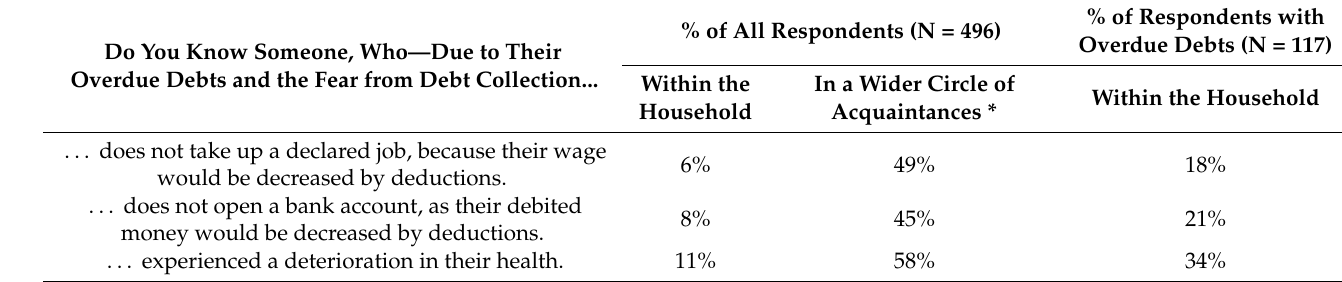
Table 1. Results of the direct